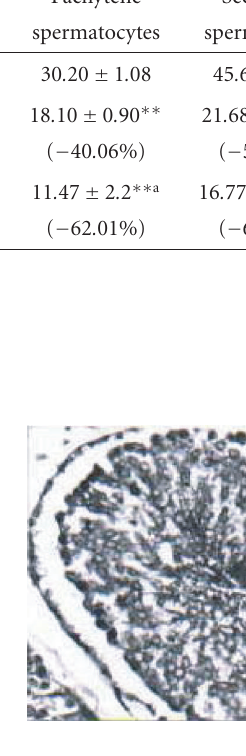
Figure 2: Microphotograph of testis of rat treated with compound 1 showing acute degenerative changes in the histoarchitecture of testis and detachment of germinal epithelial layer. Degeneration of pri- mary spermatocyte stage is seen and lumen is filled with cellular debris. X 200